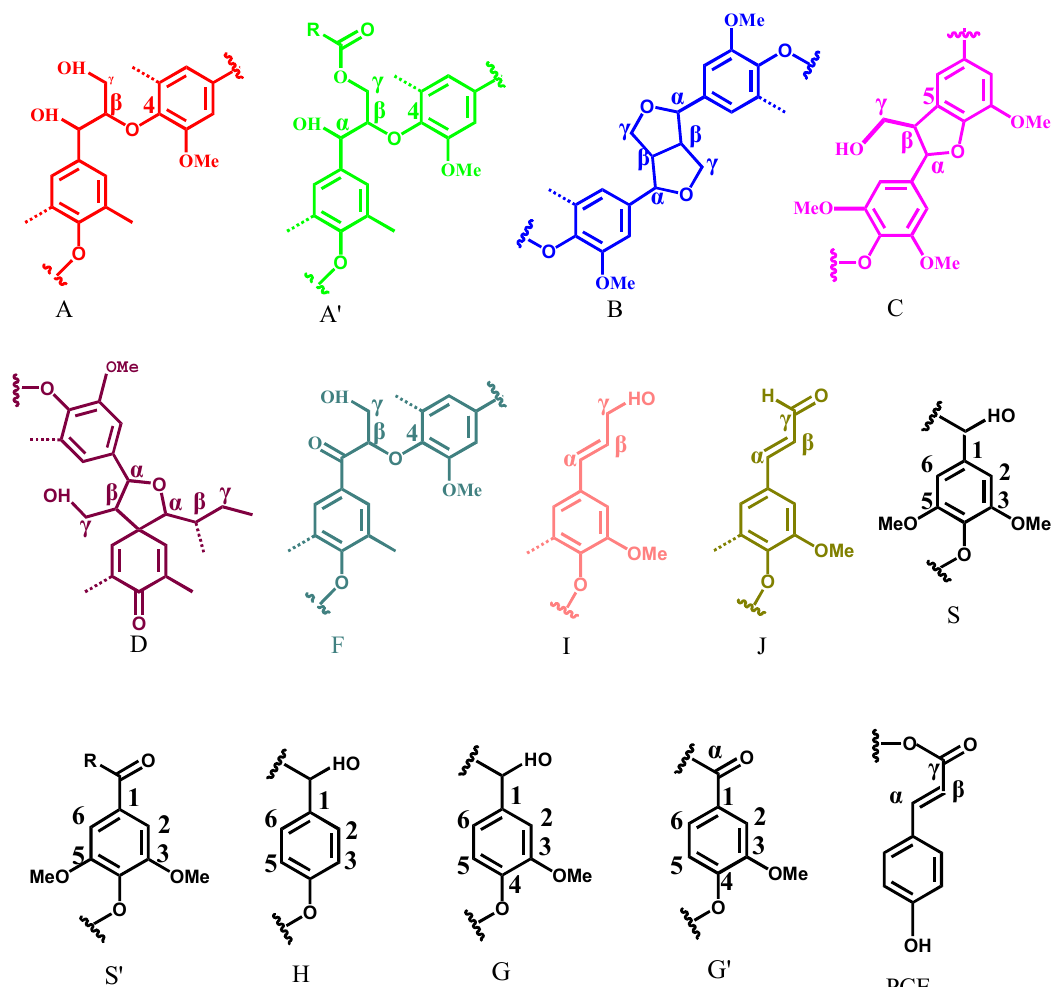
Figure 3. Main substructures of FMWL and SMWL involving various side-chain linkages, and aromatic units identified by 2D HSQC NMR: ( A ) β - O -4 ′ aryl ether linkages with a free-OH at the γ -carbon; ( A ′ ) β - O -4 ′ aryl-ether linkages with acetylated and/or p -hydroxybenzoated-OH at γ -carbon; ( B ) resinol structures formed by β - β′ / α - O - γ′ / γ - O - α′ linkages; ( C ) phenylcoumaran structures fromed by β -5 ′ / α - O -4 ′ linkages; ( D ) cinnamate unit; ( F ) C α -oxidized β - O -4 ′ substructures; ( G ) guaiacyl unit; ( G ′ ) oxidized guaiacyl units with a α -ketone; ( S ) syringyl unit; ( S ′ ) oxidized syringyl unit with a carbonyl group at C α ketone; ( H ) p -hydroxyphenyl unit; ( I ) cinnamyl alcohol end groups; ( J ) cinnamaldehyde end groups; ( PCE ) p -coumarate substructures.